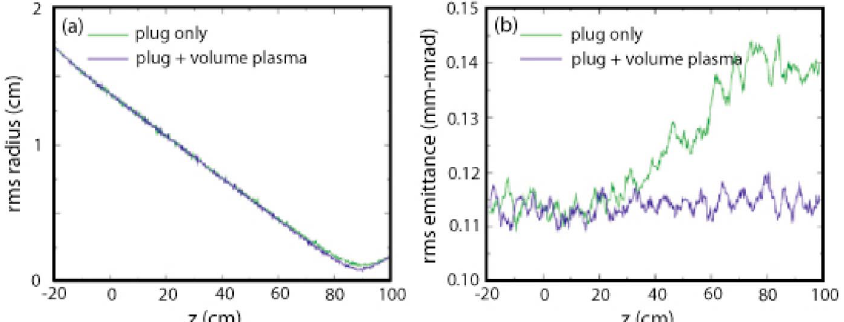
FIG. 41. (Color) Calculated (a) radius and (b) emittance of NTX beam from WARP-LSP simulations of neutralization by a plasma plug alone and combined with a volume plasma near the focal point. The rms focal-spot radius is 1.3 mm with the plug only and 0.9 mm with both